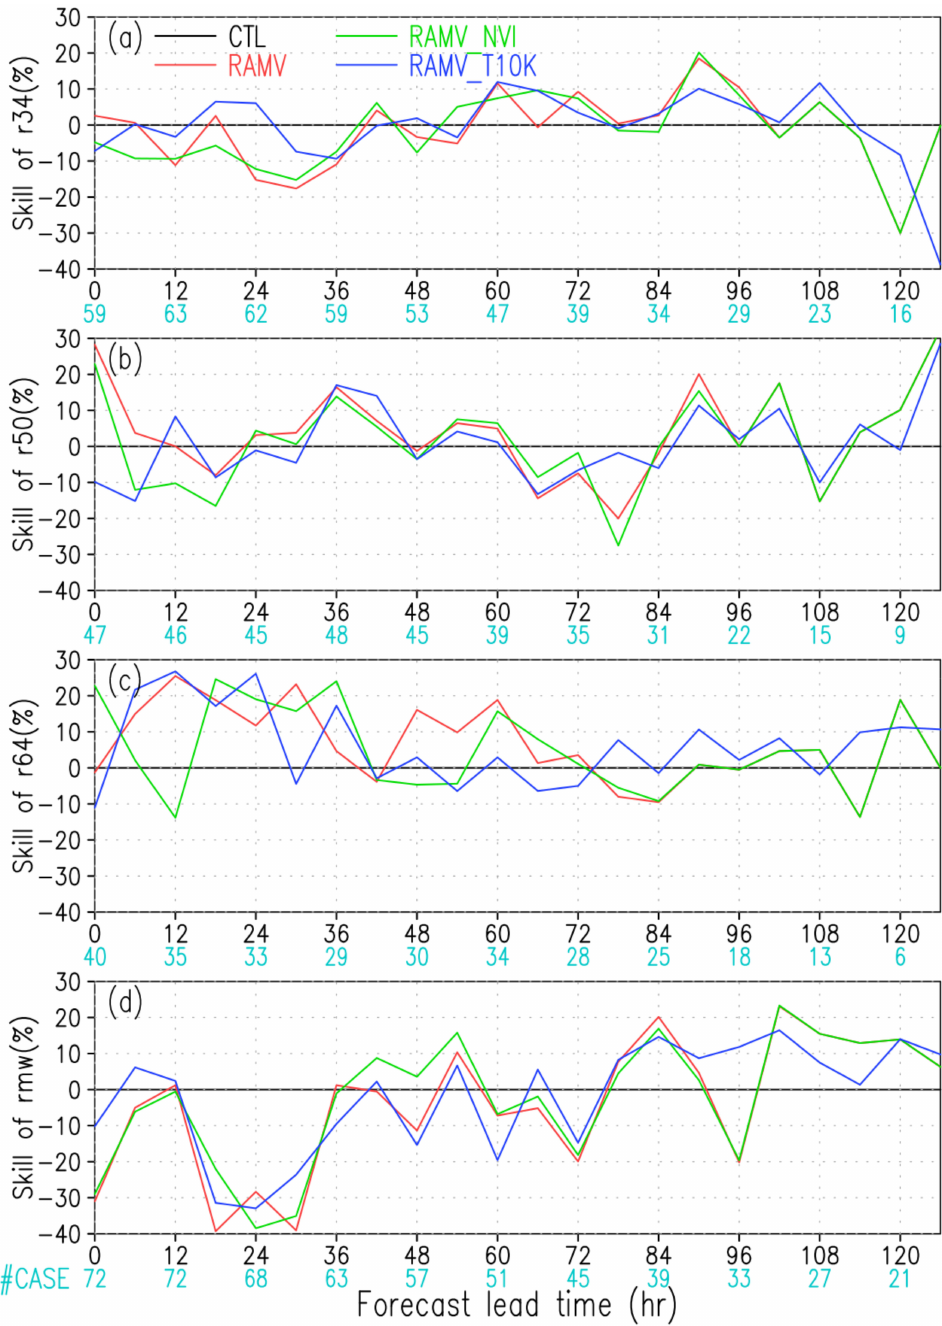
Figure 4. As in Figure 3, but for skill of ( a ) R34, ( b ) R50, ( c ) R64, and ( d )